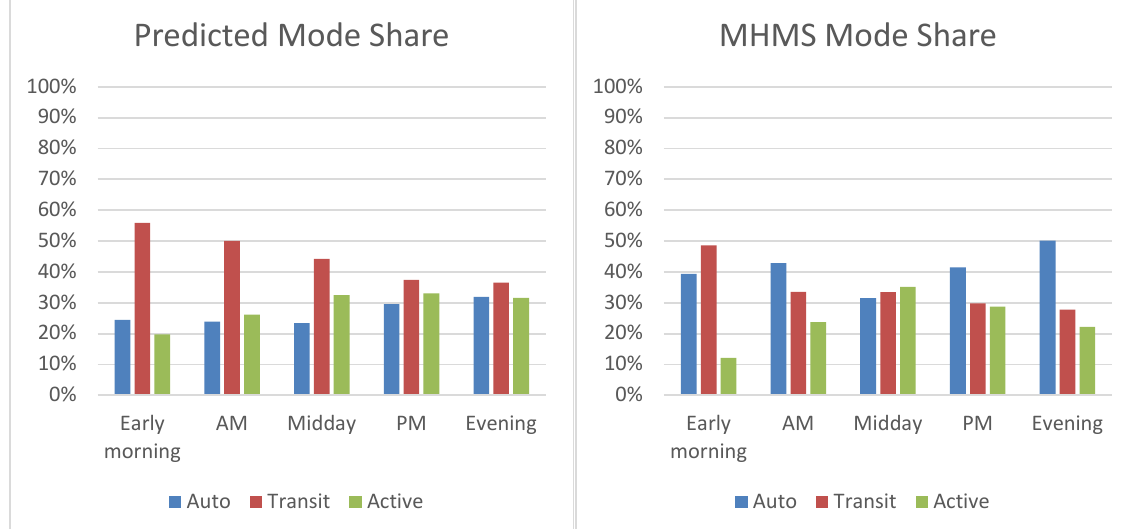
Figure 4. Predicted and Observed Mode Shares by Time of